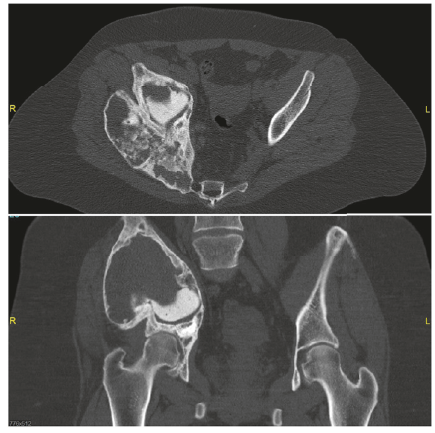
Figure 3: Follow-up CT scan of the pelvis showing stable disease after discontinuation of the second cycle of Denosumab treatment for fifteen